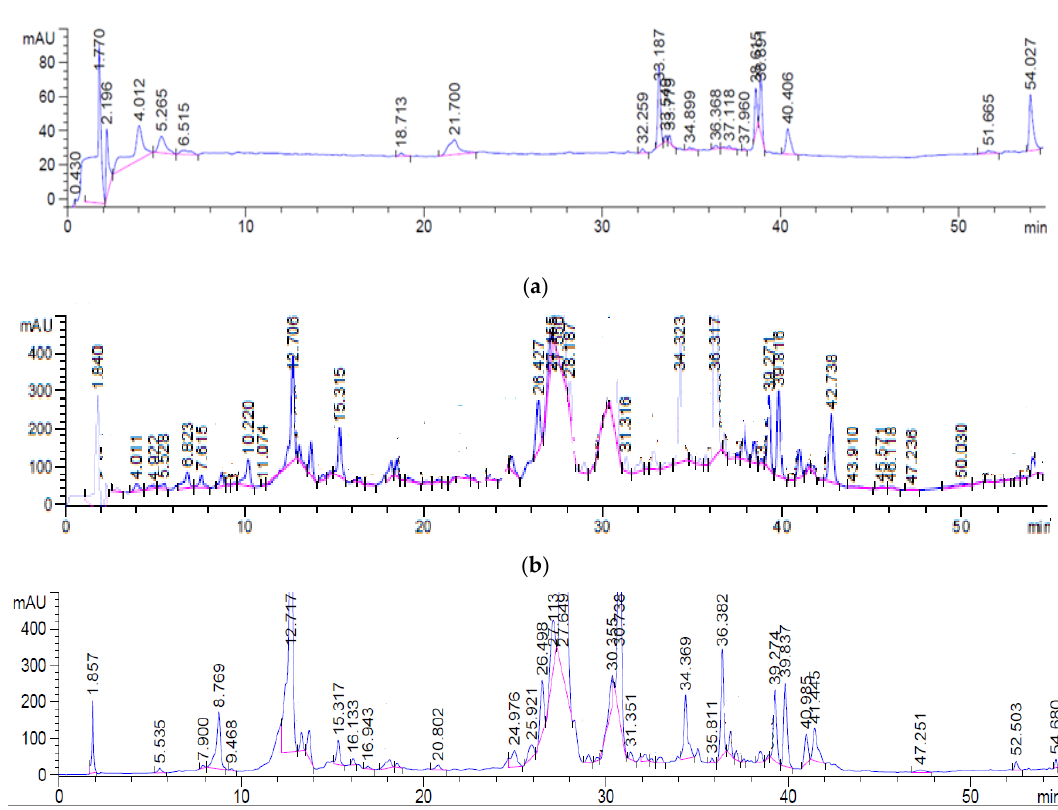
Figure 5. Chromatogram for the HPLC analysis of standards ( a ), ethyl acetate extract ( b ), and ethanol extract ( c ) of Echinops spinosissimus . Table 2. Phenolic profile of Echinops spinosissimus ethyl acetate and ethanol extracts analyzed via HPLC.